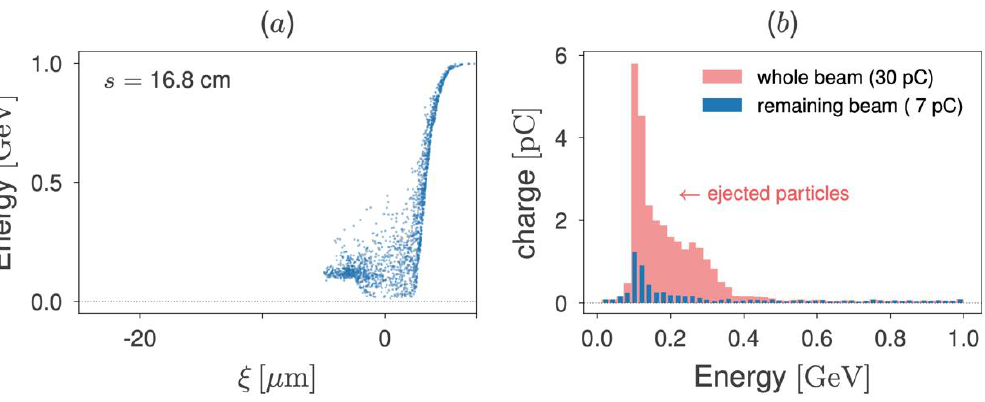
Figure 3. ( a ) The EuPRAXIA 1 GeV beam longitudinal phase space and ( b ) energy spectrum, after 16.8 cm propagation in plasma. At this propagation distance, particles with lower energies, which can be clearly seen in Figure 1a, are not present because they were ejected by the defocusing phase of the transverse wakefield. The energy spectrum for the remaining beam (7 pC, at this propagation distance) is represented by the blue columns in Figure 3b. In addition, the light-red shaded region shows the energy and charge distribution for the whole beam, including the transversely ejected particles.